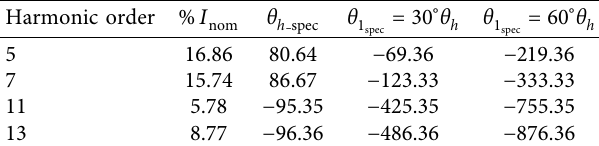
described below highlight some aspects of harmonic summation.